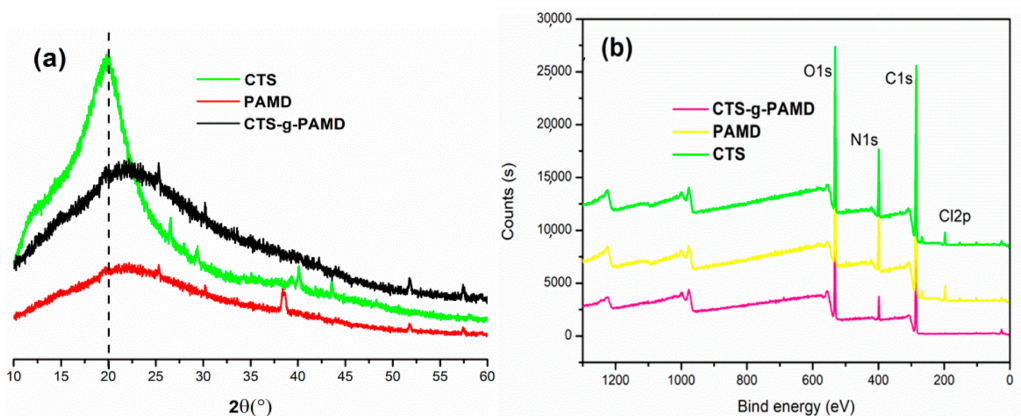
Figure5. The( a )X-raydi ff raction(XRD)and( b )X-rayphotoelectronspectroscopy(XPS)ofthepolymers.